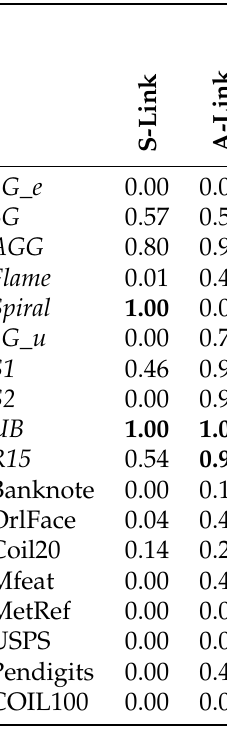
Table 5. The ARI scores of different methods on different datasets. The best performance on each dataset is highlighted in bold. The names of synthetic datasets are in